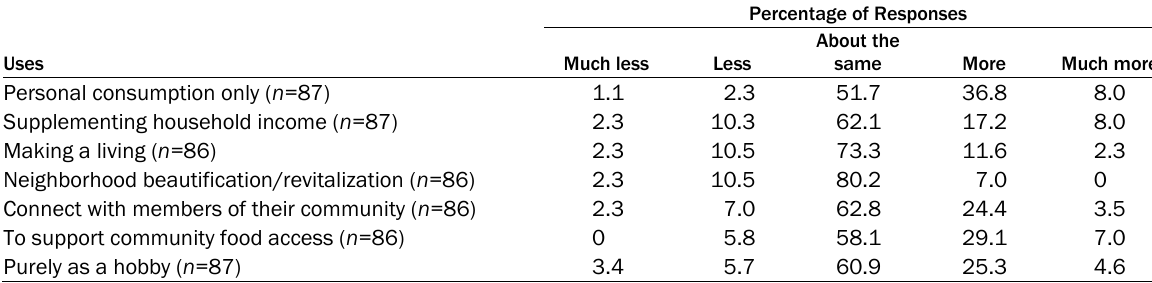
Table 10. Perceived Change in How Local Food Producers in Respondents’ Community Were Using Their Products Following